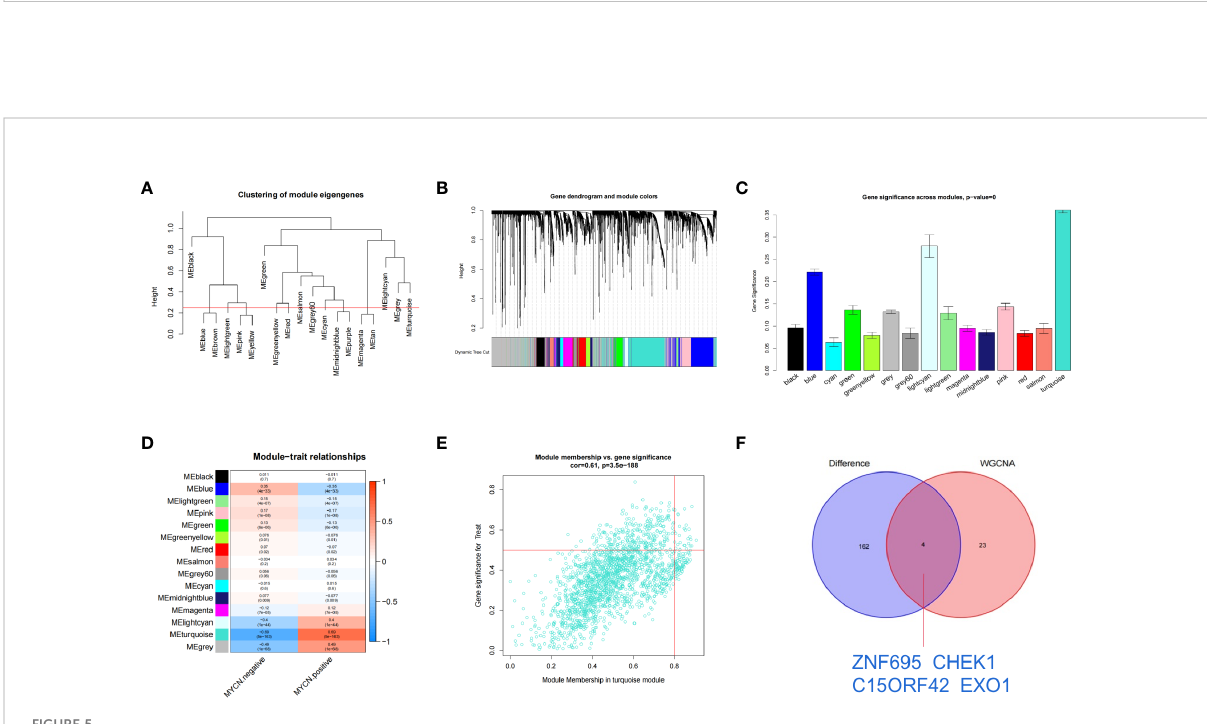
FIGURE 5 Identi fi cation of clinically signi fi cant module and hub genes by WGCNA (A) As shown in the hierarchical clustering tree, 19 modules were screened out and similar modules were further combined into 15 modules based on WGCNA (Red line: MEDissThres = 0.25). (B) Merged dynamic tree of genes with dissimilarity based on topological overlap and assigning module colors. (C) Diagram of correlation of NB and module ’ s color. The turquoise module was most closely related to MYCN . (D) Heatmap of the correlation between MYCN expression and module eigengenes. The turquoise module had the lowest p value and was selected as our next research object. (E) Scatterplot analysis of turquoise modules. core genes were fi ltered in the upper right region of GS > 0.5 and MM > 0.8. (F) Displays the Venn plot of 27 core genes in turquoise modules and 166 DEGs (|log2fc| > 2 and p-value <